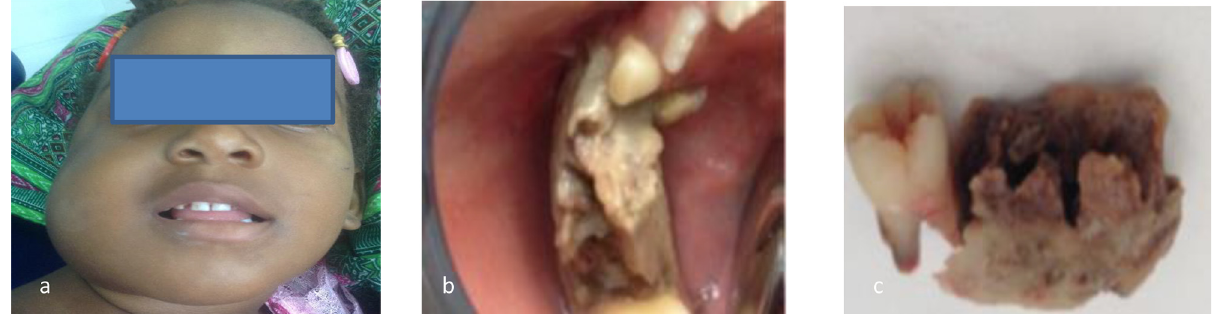
Fig. 2. Voluminous swelling owing to odontogenic maxillary osteitis in a child (a). Intraoral view of the bone sequestrum (b) and operative specimen after sequestrectomy